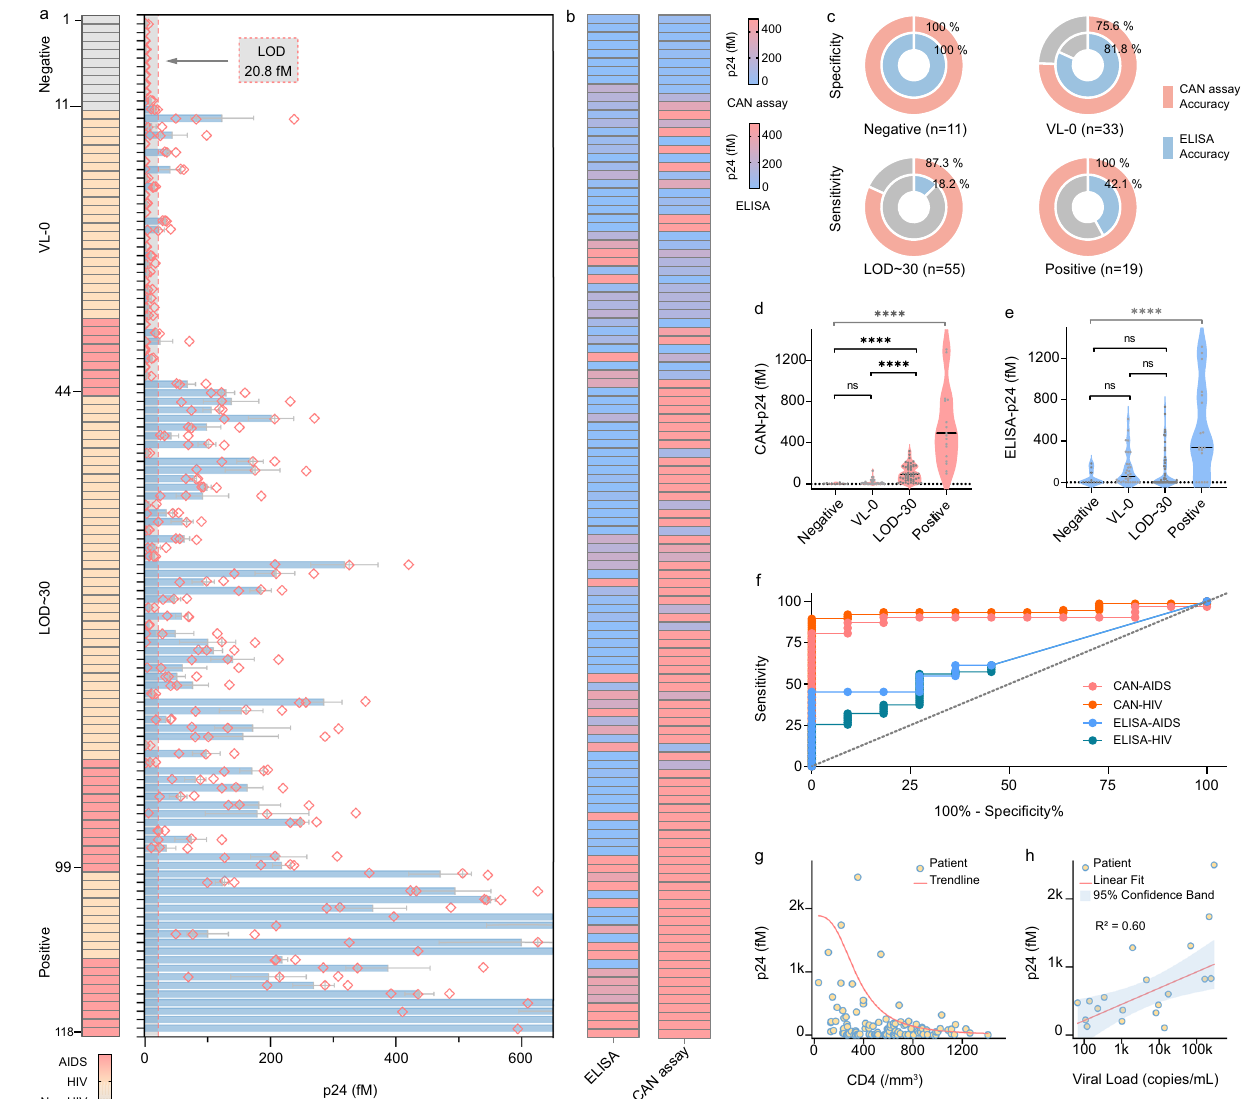
Fig.5|Clinicalvalidationinapilotcohort.a Quantitativemeasurementsofp24in clinicalsamplesusingtheCANassay,withtheclinicaldiagnosisofeachpatient.Bar graph data represents mean±SD of replicates ( n =3 biologically independent experiments, totalevents N >1000 for eachsample, detailed informationshownin Supplementary Table 3). Each red diamond represents the result from one experiment. The dashed line indicates the LOD of the CAN assay. b Cluster map produced from p24 results measured by the CAN assay and ELISA for 118 eligible patients. Blue color indicates results below LOD. c p24 detection accuracy for the CAN assay and ELISA in different patient groups using VL as reference (Negative: n =11; VL-0: n =33; LOD~30: n =55; Positive: n =19). d , e Average levels of p24 concentrations obtained by d the CAN assay and e ELISA for different patient groups. Each point represents an independent clinical individual (Negative: n =11; VL-0: n =33; LOD~30: n =55; Positive: n =19). Each solid line represents mean p24